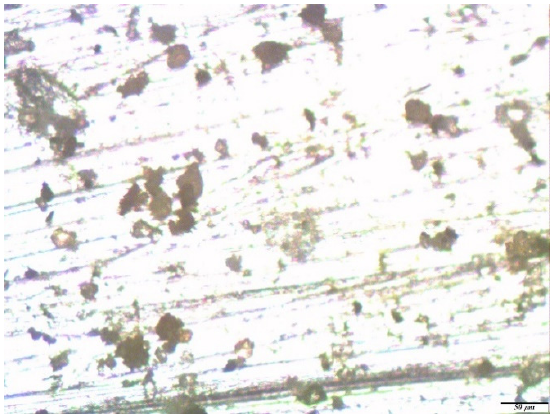
Figure 11. Micrograph of the surface area of an unmodified aluminum sample after conducting full-scale, one-year tests in an urban atmosphere, after the removal of the corrosion products.